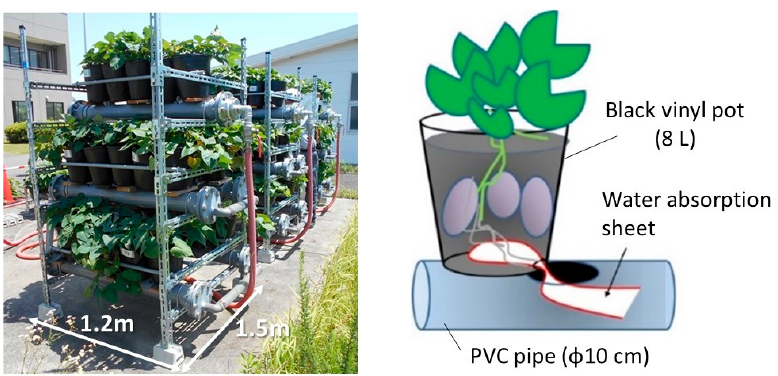
Figure 10. The three-layer cultivation system with rhizosphere irrigation.